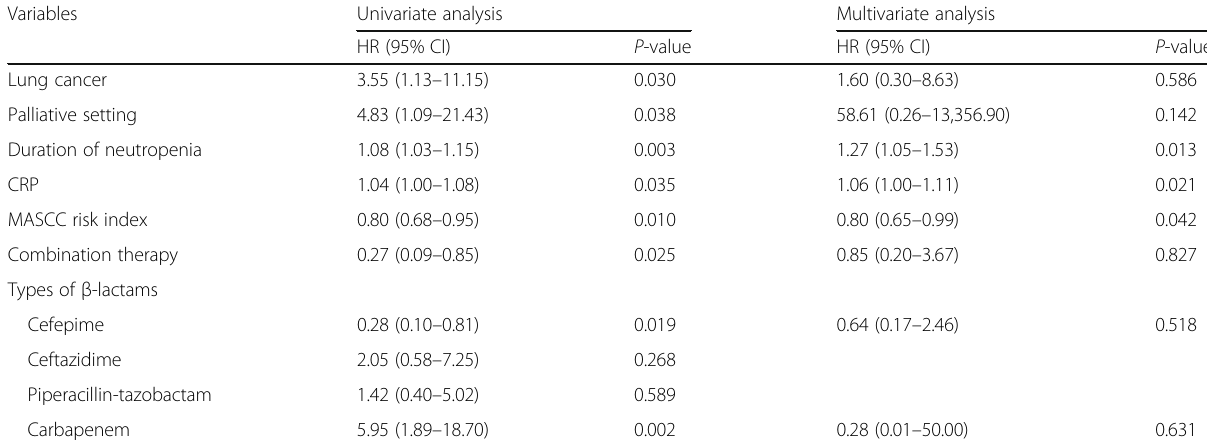
Table 4 Multivariate analysis of 30-day all-cause mortality due to neutropenic pneumonia